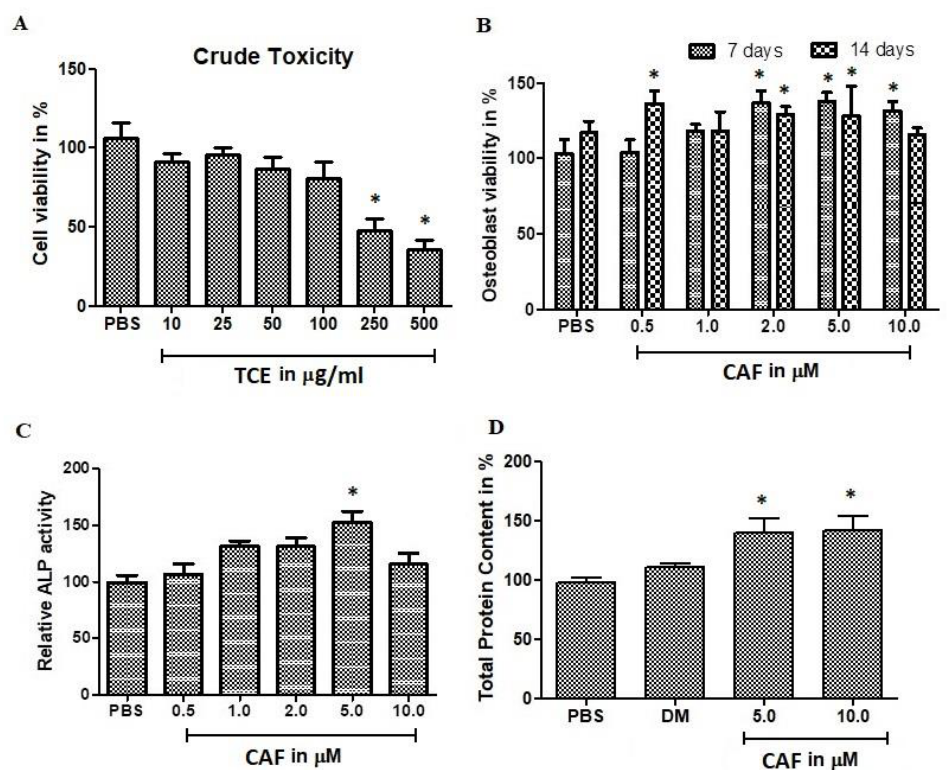
Figure 2. In vitro cytotoxic evaluation of T. stellata crude extract (TCE) and its metabolites. ( A ) The osteostromal cells were isolated from murine bone marrow and osteogenic characters were induced. The osteogenic cells were further analyzed for cytotoxic effect against T. stellata crude extract. The concentration tested from 10 μM to 500 μM. The crude extract was treated with osteogenic cells for 72 h and evaluate the cell viability using MTT reagent. ( B ) The major metabolites caffeic acid (CAF) was treated with osteogenic cells in concentration of 1.0 μM to 50 μM for 7 days and 14 days cultured cells. ( C ) Alkaline phosphatase-specific activity. ( D ) Total protein content. Bars represent the mean ± SD ( n = 4). Statistical results are shown as * p < 0.05, Values compared between the PBS group with CAF at different concentrations.